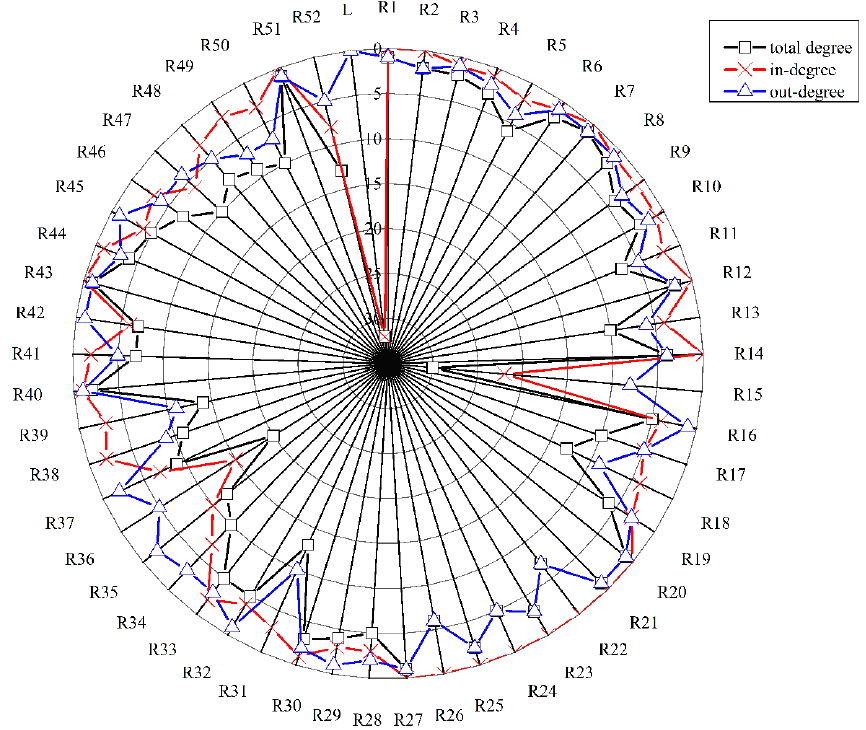
Figure 4. In-degree, out-degree and total degree of COR